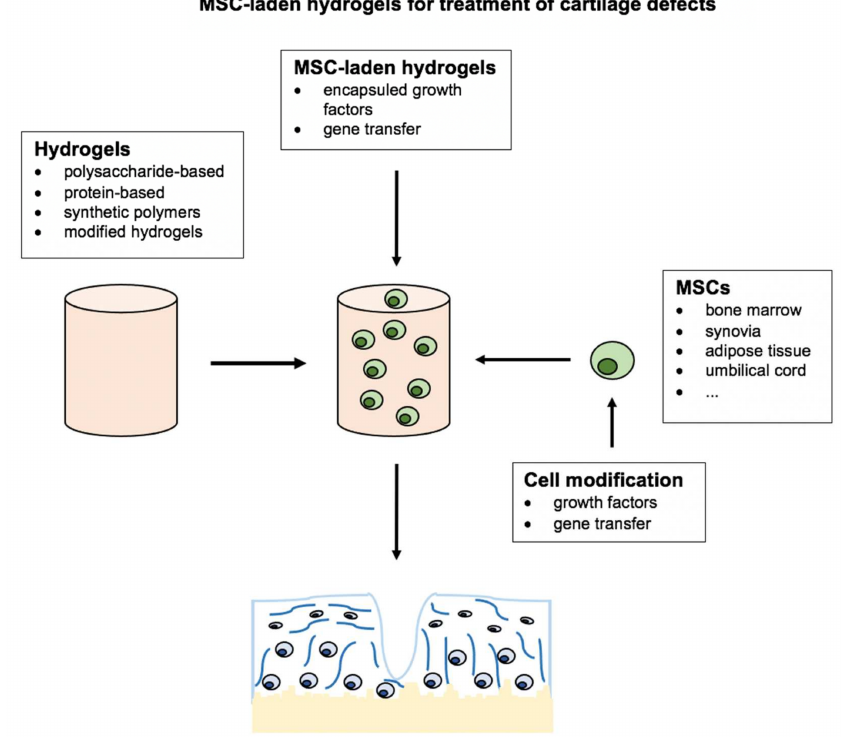
Figure 2. Combinations of hydrogels, mesenchymal stromal cells, and gene transfer, as well as growth factors for cartilage tissue engineering. Image-based on Deng et al., 2020 [14]: Narrative review of the choices of stem cell sources and hydrogels for cartilage tissue